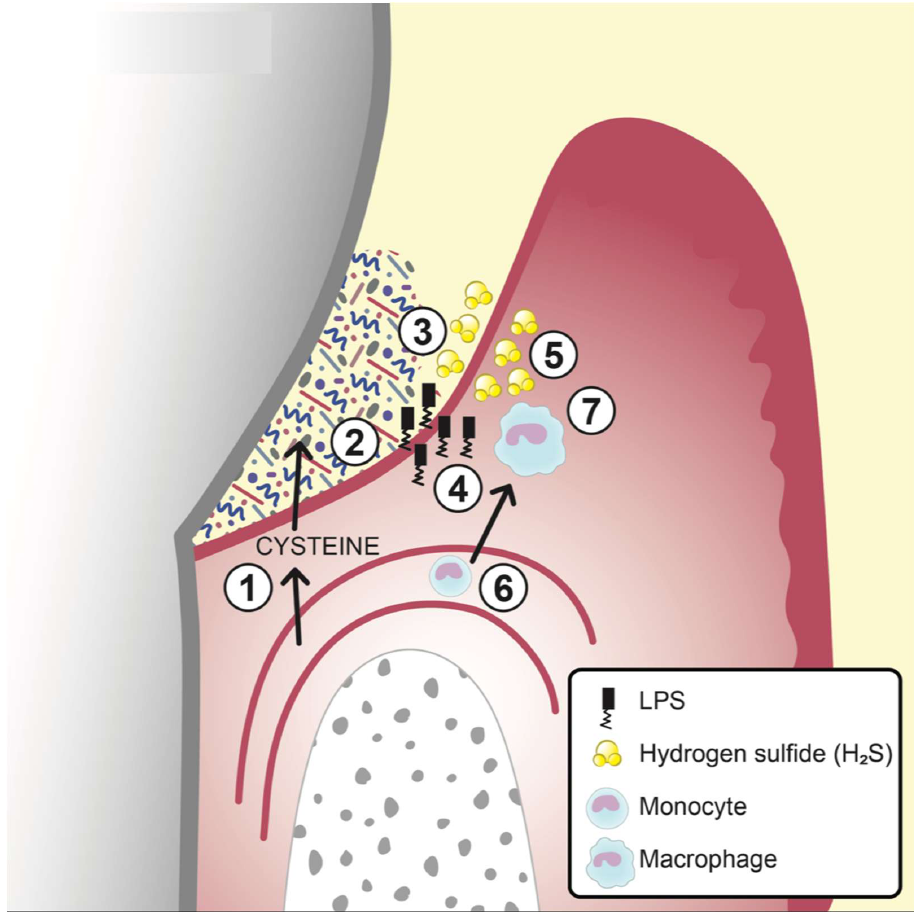
Figure 1. A schematic figure of an inflamed gingival pocket with subgingival plaque (biofilm) and the two signals that lead to the production and secretion of IL-1ß and IL-18 from monocytes/macrophages as reprinted from Basic et al. [59]. The numbers in the figure indicates the following: 1. Serum exudate from blood vessels containing serum proteins, peptides and amino acids including cysteine. 2. The exudate (gingival crevicular fluid, GCF) continues through the thin pocket epithelium (junctional epithelium) into the subgingival pocket. 3. The subgingival plaque, containing numerous, mainly Gram-negative, anaerobic bacteria with proteolytic capacity, degrade proteins, peptides and amino acids including cysteine. 4. Growing Gram-negative anaerobes release lipopolysaccharides (LPS) that penetrate the junctional epithelium into gingival connective tissues. 5. Growing Gram-negative anaerobes ( Fusobacterium spp. P. gingivalis , Treponema spp, and others) produce metabolites e.g. hydrogen sulfide (H 2 S). 6. The inflammatory lesion attracts monocytes that migrate into the connective tissue and differentiate to macrophages. 7. The effect of LPS and H 2 S on macrophages and the subsequent production of the pro-inflammatory cytokines IL-1β and IL-18. Various carboxylic acids, i.e., acetic acid, butyric acid, formic acid, isobutyric acid, isovaleric